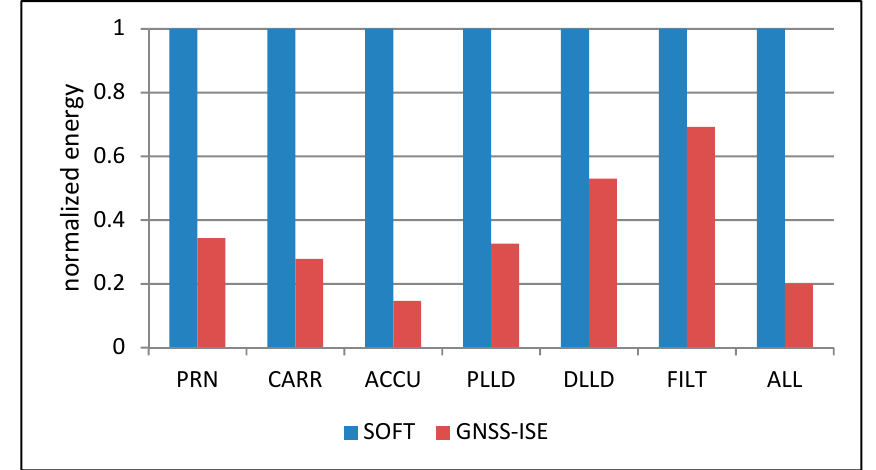
Figure 12. Normalized power consumption during execution of tracking loop tasks with GNSS-ISE and without GNSS-ISE.